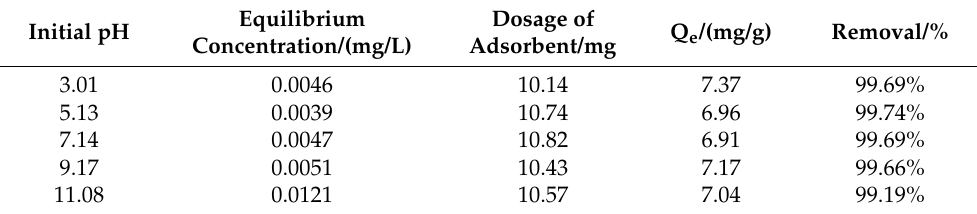
Table 2. Effect of pH on H 3 AsO 4 removal by iowaite.